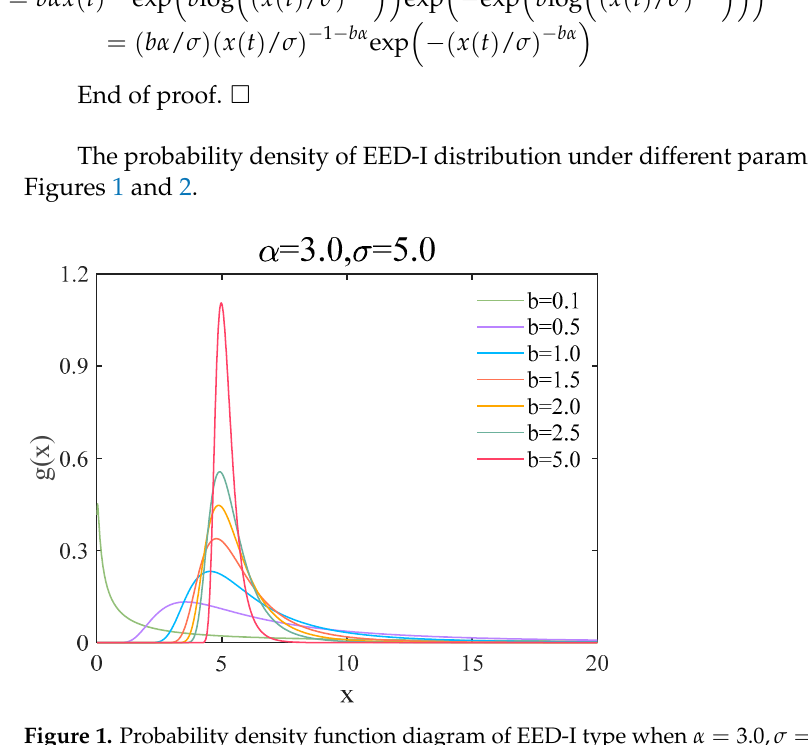
Figure 1. Probability density function diagram of EED-I type when α = 3.0, σ = 5.0.